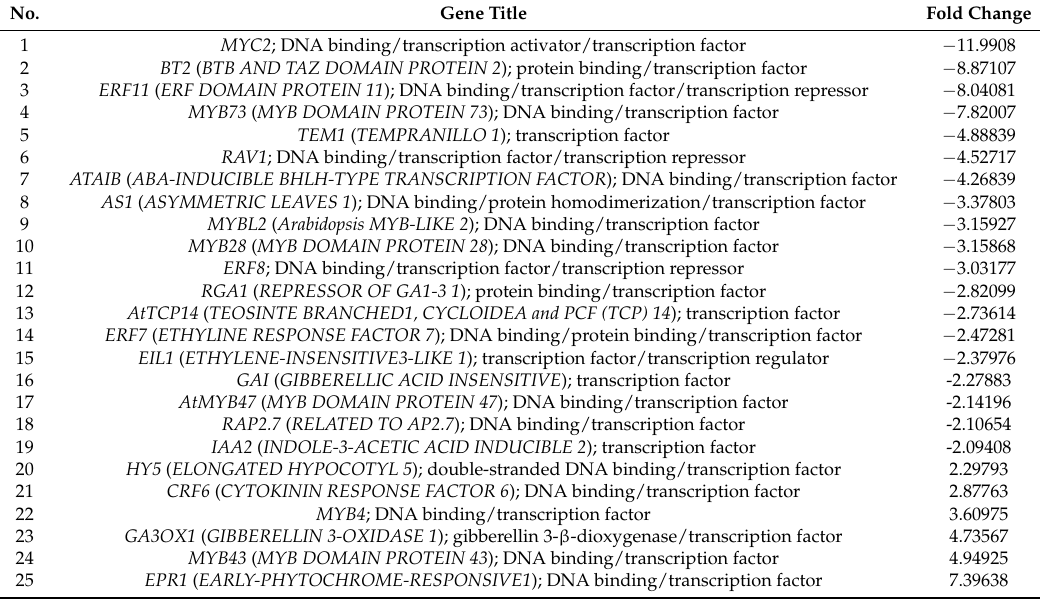
Table 2. Phytohormone metabolism transcription factors involved in heat stress response (positive “Fold Change” means upregulated after HS; negative means downregulated). These TFs implicate that phytohormones play essential roles in heat stress response in